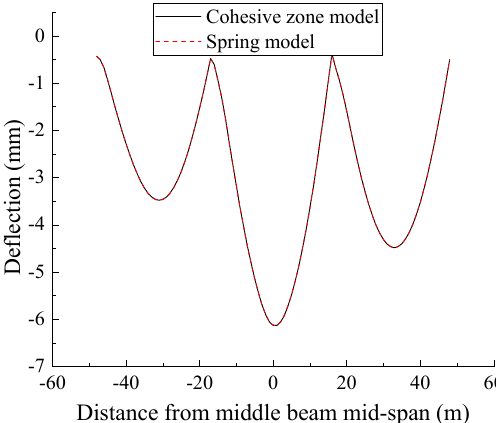
Figure 15. Deflection curves of the beam with the different interfaces bond model under static load.